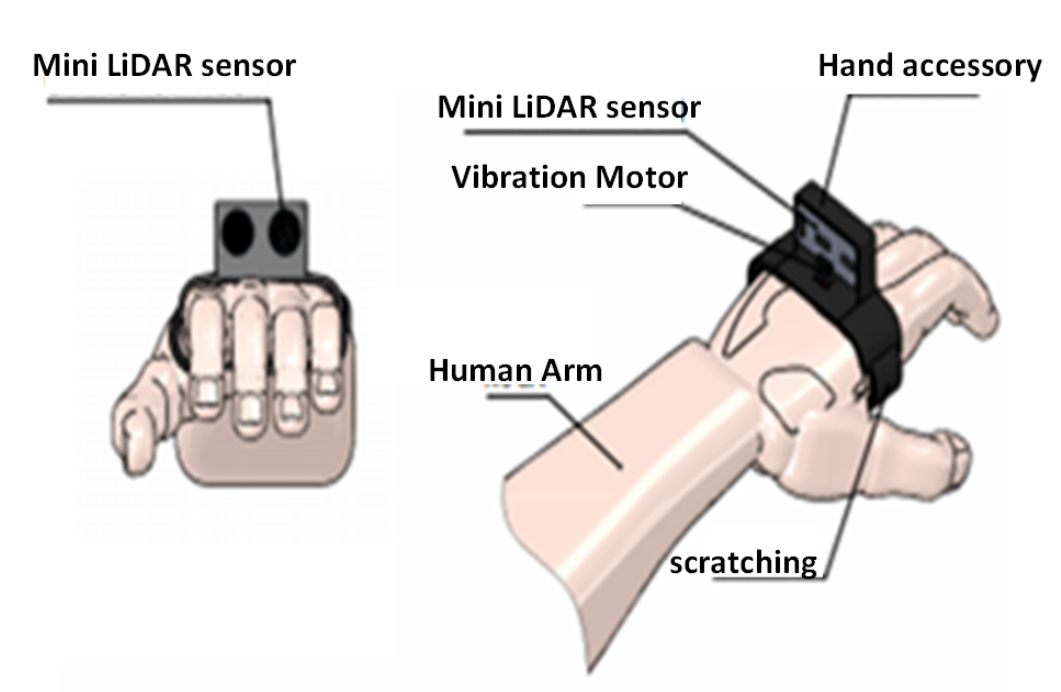
Figure 4. Wearable hand accessory to detect lower objects and the corresponding 3D geometric